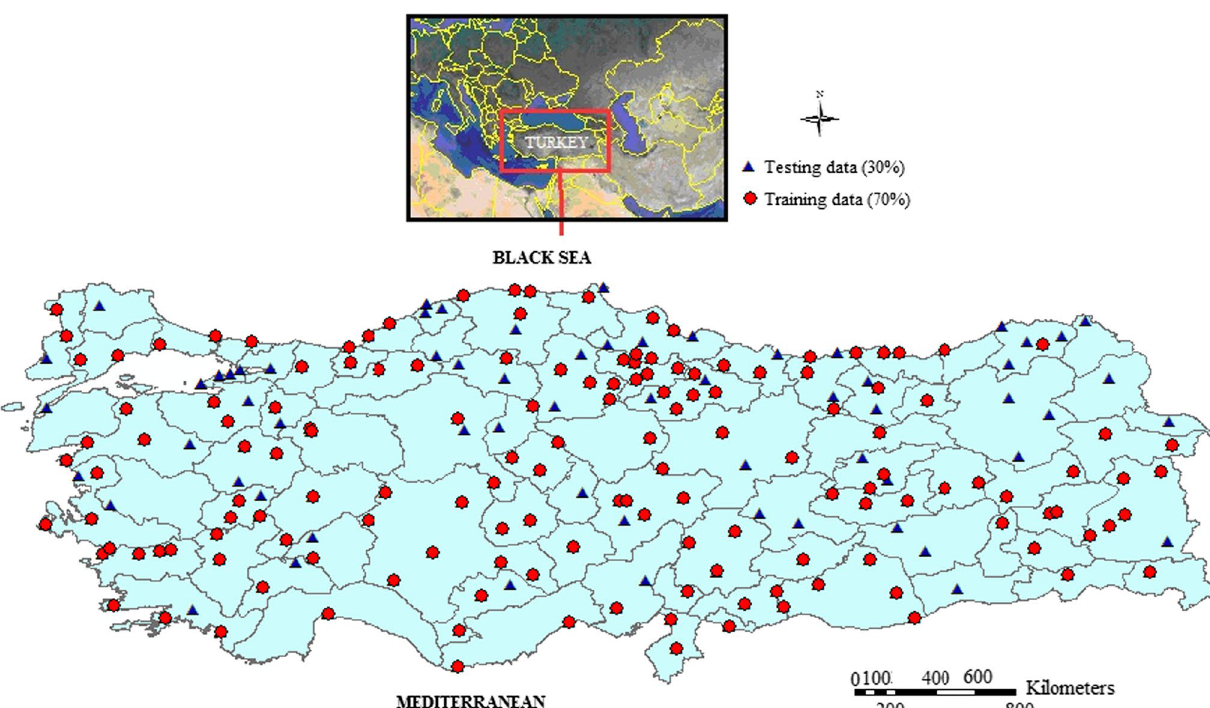
Fig. 1 Distribution of meteorological